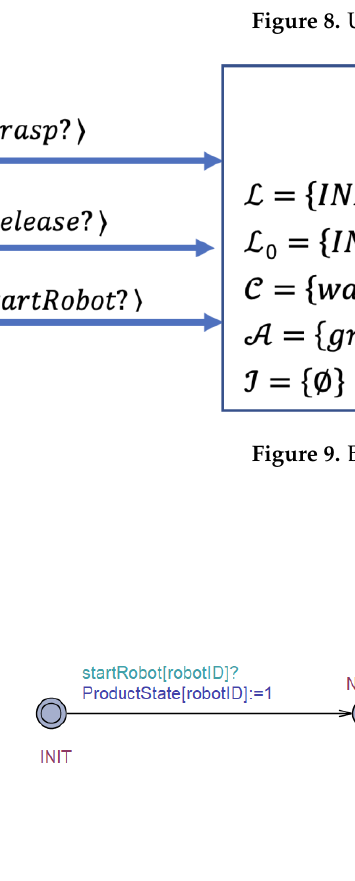
Figure 10. UPPAAL timed automata model of product detector.